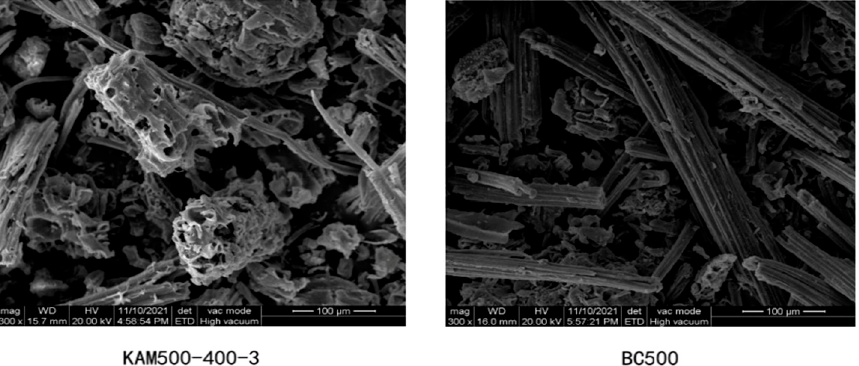
Figure 1. SEM images of bamboo charcoal and modified bamboo charcoal.